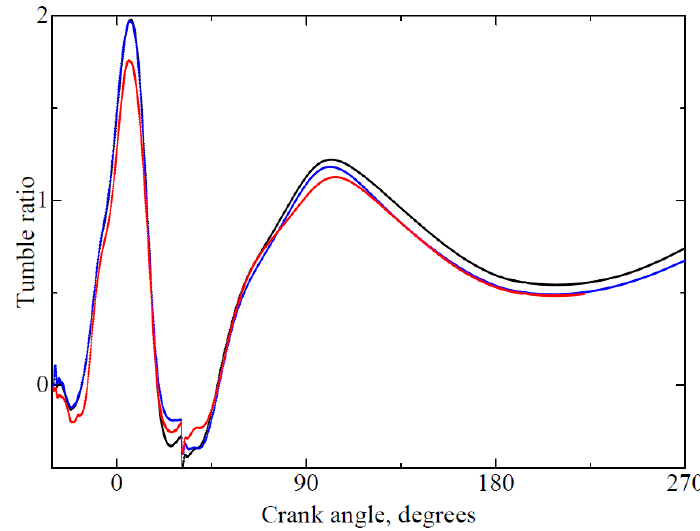
Figure 5. Grid independence test for the Tumble Ratio.